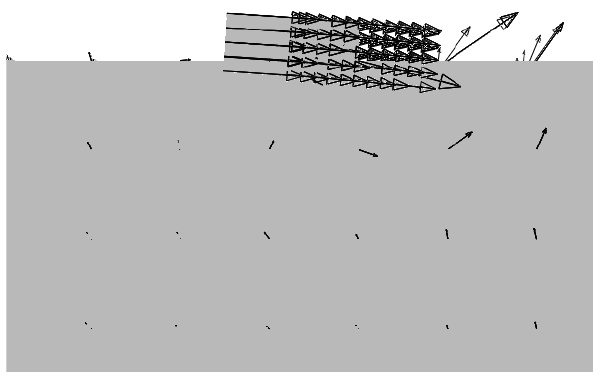
Figure 13. Soil flow mechanisms at failure. The front soil is actively damaged by gravity anchors and is greatly deformed. The soil area behind the anchor is passive. The posterior soil is not affected by the gravity